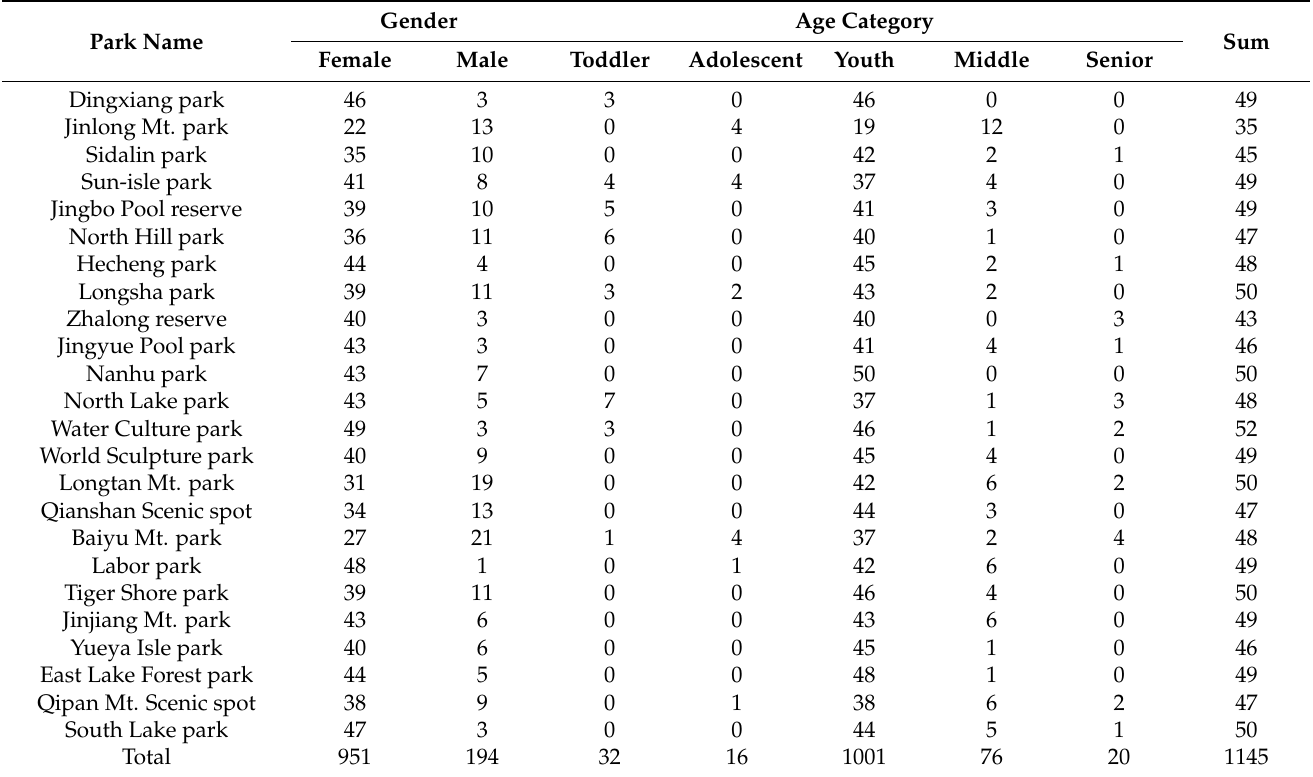
Table 2. Number of gender and age variations for visitors in urban forest parks at Northeast